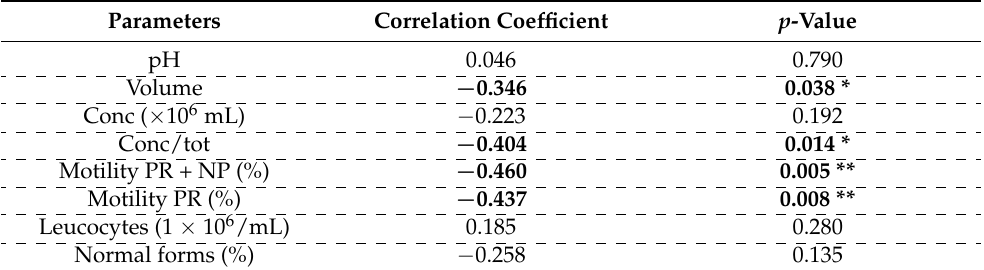
Table 1. Correlation between the sperm parameters of the Test group and infective